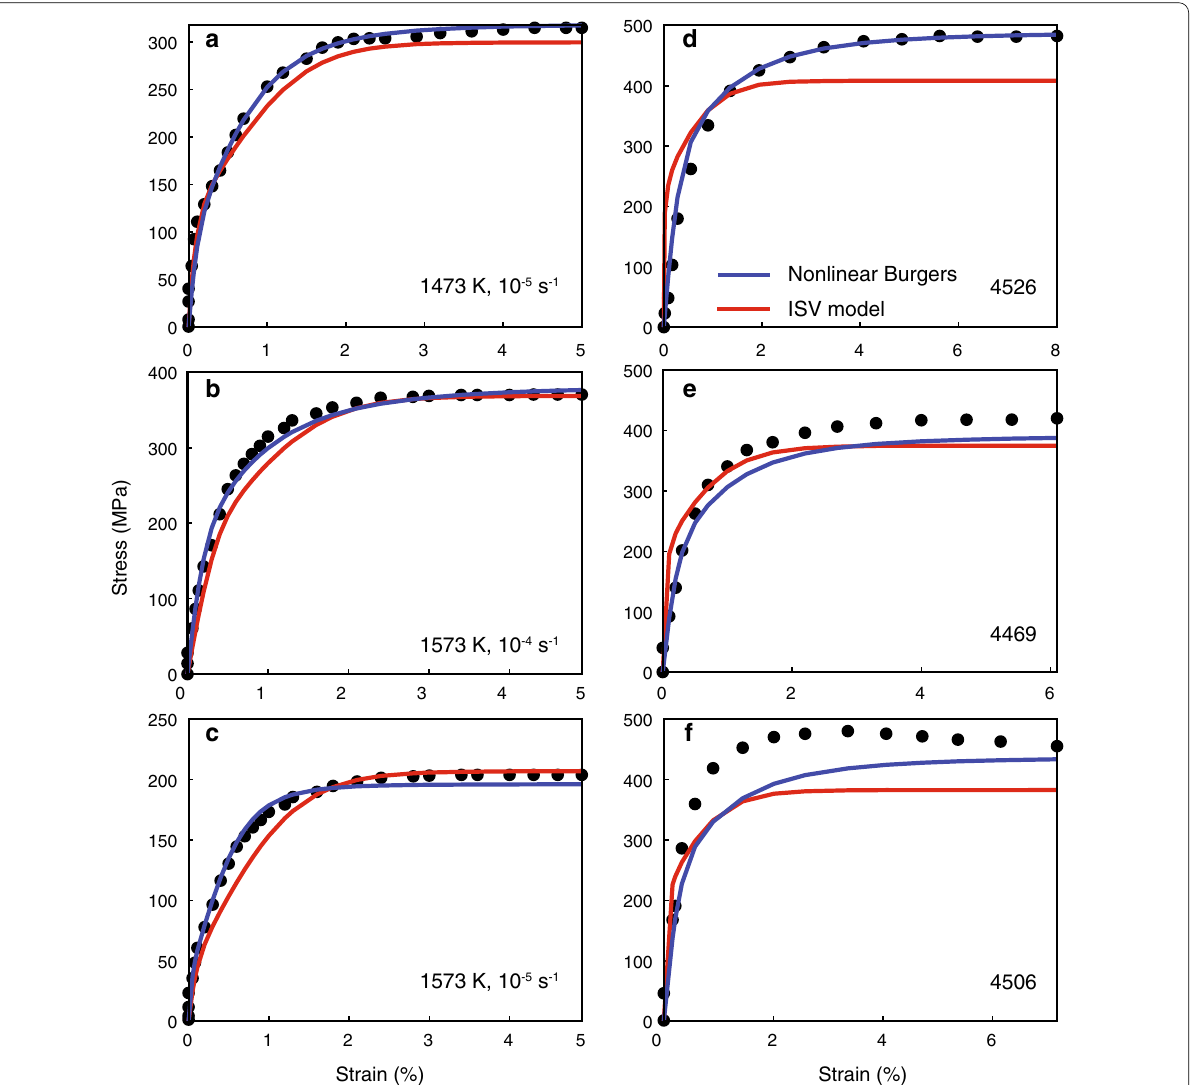
Fig. 5 Stress-versus-strain data and best-fitting predictions of the ISV and nonlinear Burgers models for dunites in anhydrous conditions. a – c ) The model fits to the data used by Sherburn et al. (2011). All the constants from C 1 to C 20 are from Table 1 of Sherburn et al. (2011), except for C 13 = 0.83 , which corrects a typographic error. The reduced chi-square value for the ISV and nonlinear Burgers models are 41.1 and 13.9, respectively, indicating that the nonlinear Burgers model performs better than ISV. d – f Comparison with data not used in the optimization. Reduced chi-square values for the ISV and nonlinear Burgers models on these data are 411.2 and 105.1, respectively. The nonlinear Burgers model, which uses fewer parameters compared to the ISV model, performs